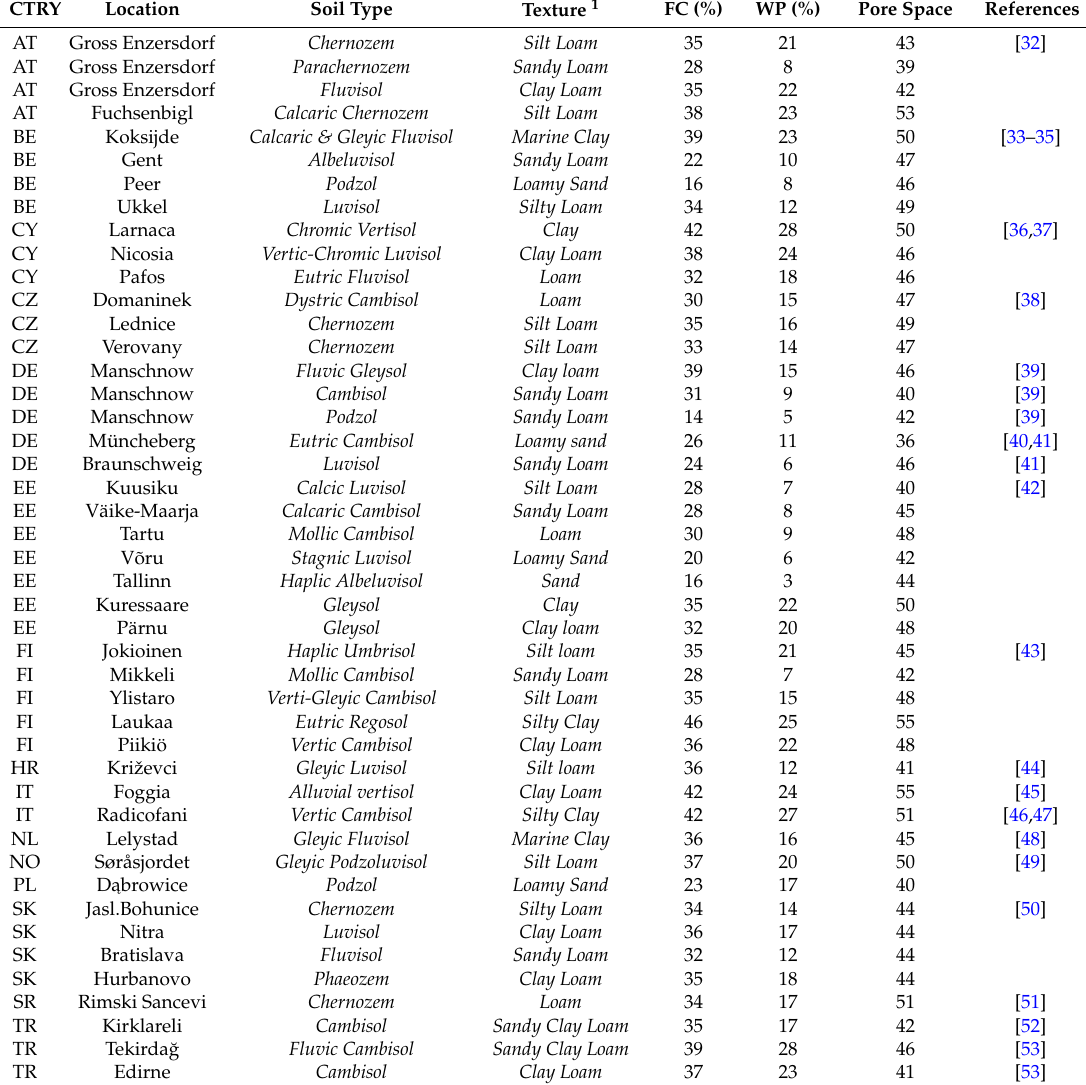
Table A1. Soil hydrological properties of the topsoil for different locations across Europe. CTRY